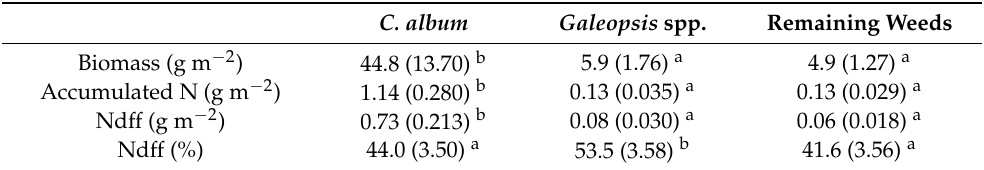
Table 3. Biomass, N accumulation and N derived from fertilizer (Ndff) of Chenopodium album , Galeopsis spp. and the remaining weeds. Different letters indicate significant differences between the species following pairwise comparison (Tukey, α = 0.05) based on ln-transformed data, except for Ndff (%).Values presented are estimated medians in case of back-transformed data and estimated means (for Ndff (%)). Standard errors are given in parenthesis. Back-transformed means (estimating medians) and standard errors were obtained by back-transformation via the delta method. The original estimates based on ln-transformed data are presented in Table A3. C. album